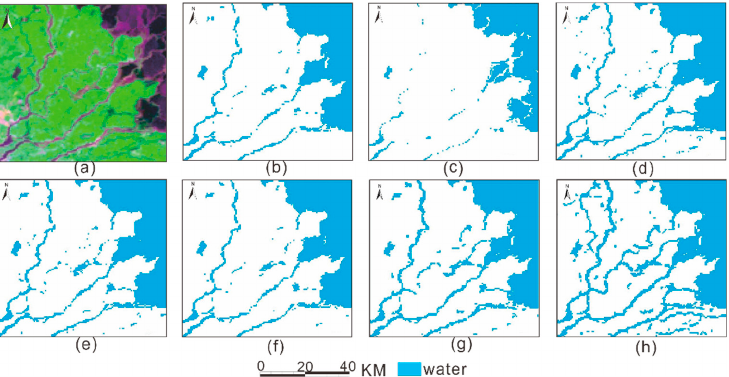
Figure 12. Extraction results of tributary water in the study area: ( a ) FY-3 / MERSI image; ( b ) single-band threshold method; ( c ) water index method; ( d ) decision tree method; ( e ) supervised classification; ( f ) unsupervised classification; ( g ) SMDPSO; ( h ) SMDPSO+LFE.